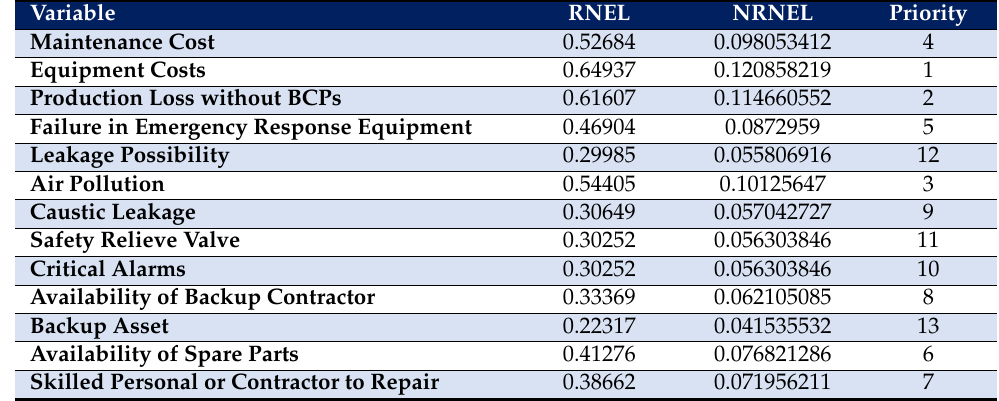
Table 13. Variables priorities based on expected asset criticality